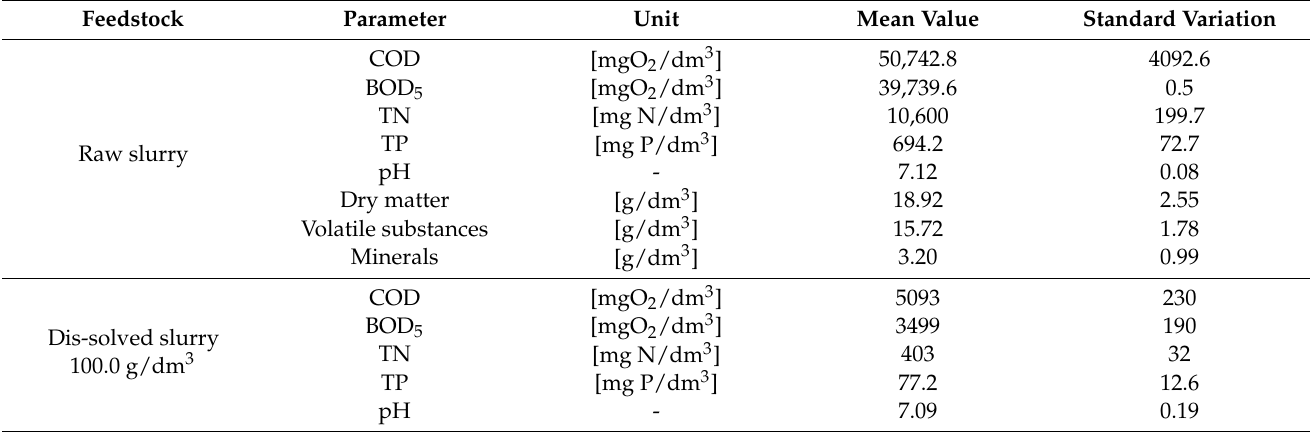
Table 1. Profile of raw and dis-solved cattle slurry used during the